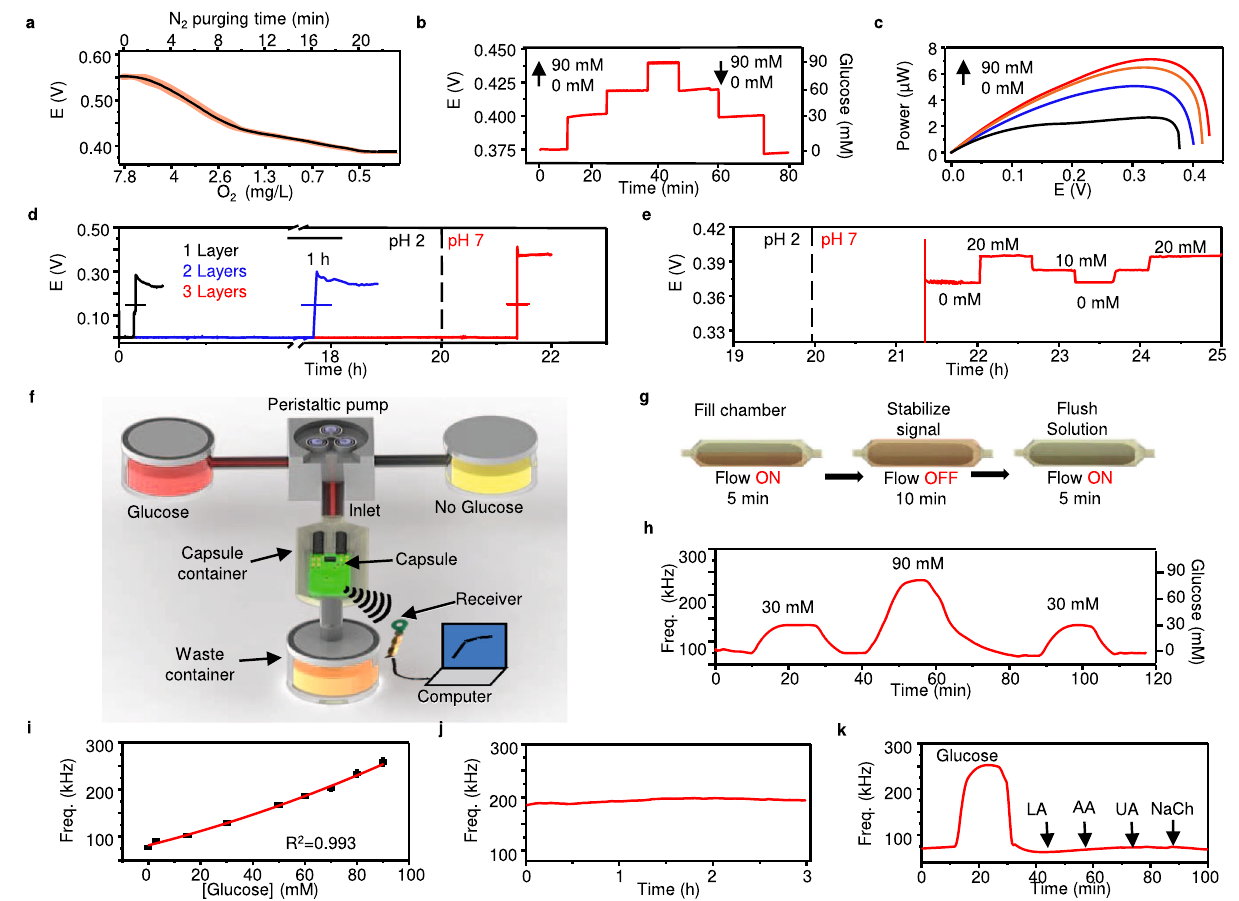
Fig.3|InvitrocharacterizationandsimulationoftheglucoseBFCunderclose- to-real physiological conditions inside the GI. a Measurement of the BFC potential under 200 k Ω load with 30mM glucose at different O 2 concentrations duringdifferentN 2 purgingtimes.Theredshadedarearepresentstheinter-sample fl uctuations, n =4 independent experiments were performed. b BFC voltage response under 200 k Ω load toward ascending the descending glucose con- centrations (0, 30, 60, and 90mM). c Power of BFC under different glucose con- centrations characterized via linear sweep voltammetry. Scan rate, 5mVs − 1 . d pH- sensitive enteric coating optimization with 1,2, and 3 layers of Eudragit® L100 coating in acidic arti fi cial gastric fl uid for 20h followed by neutral arti fi cial intest- inal fl uid.Dataarepresentedasmeanvalues+/ − SD.Horizontalerrorbarsrepresent inter-sample variations, n =3 independent experiments were performed.